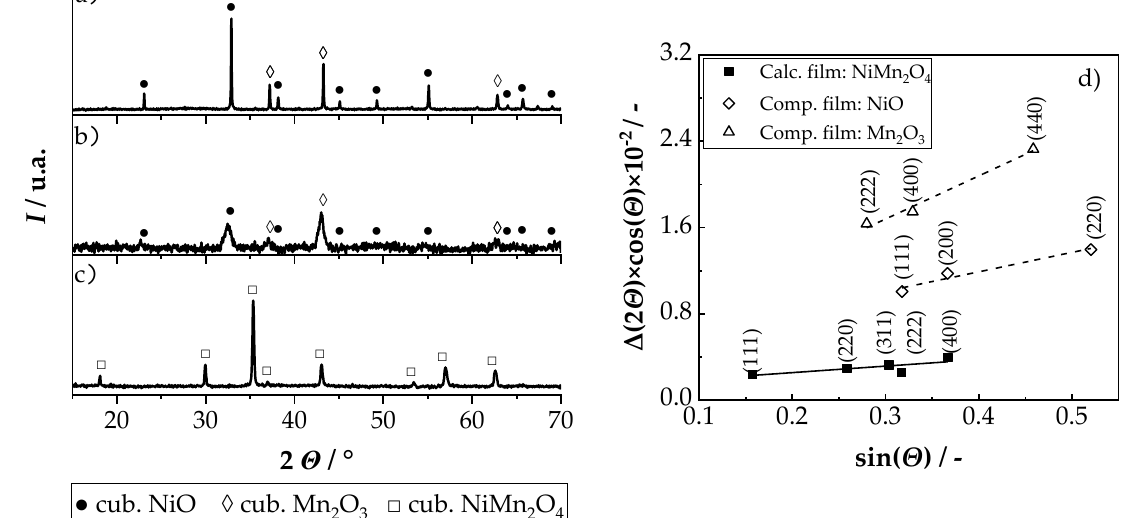
Figure 4. XRD spectra of ( a ) starting powders, ( b ) AcD film in the as-deposited state, ( c ) AcD film after calcination and ( d ) Williamson–Hall plots of NiO and α -Mn 2 O 3 in composite film in the as-deposited states and NiMn 2 O 4 after calcination of the composite film; (NiO: PDF-Nr. 01-073-1523; α -Mn 2 O 3 : PDF-Nr. 01-078-0390; NiMn 2 O 4 : PDF-Nr. 01-084-0542).